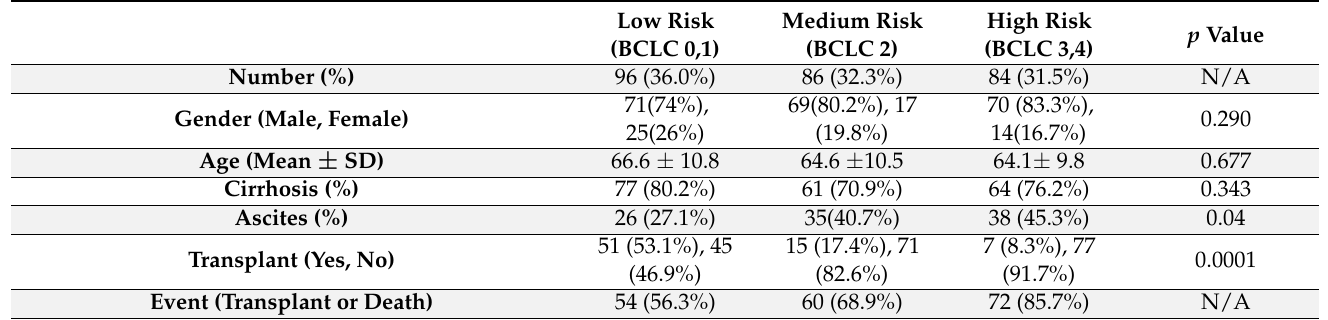
Table 1. Demographic, biochemical lab results, clinical staging, and semantic imaging findings of patients included in the present